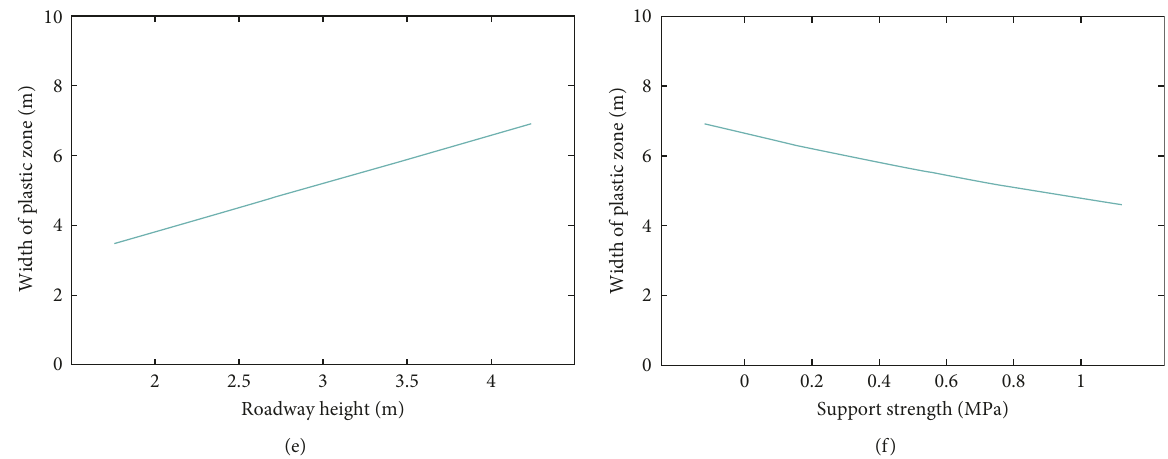
Figure 4: Parametric analysis of the width of plastic zone. (a) The interfacial friction angle. (b) The interfacial cohesion. (c) The coal friction angle. (d) The coal cohesion. (e) The roadway height. (f) The support